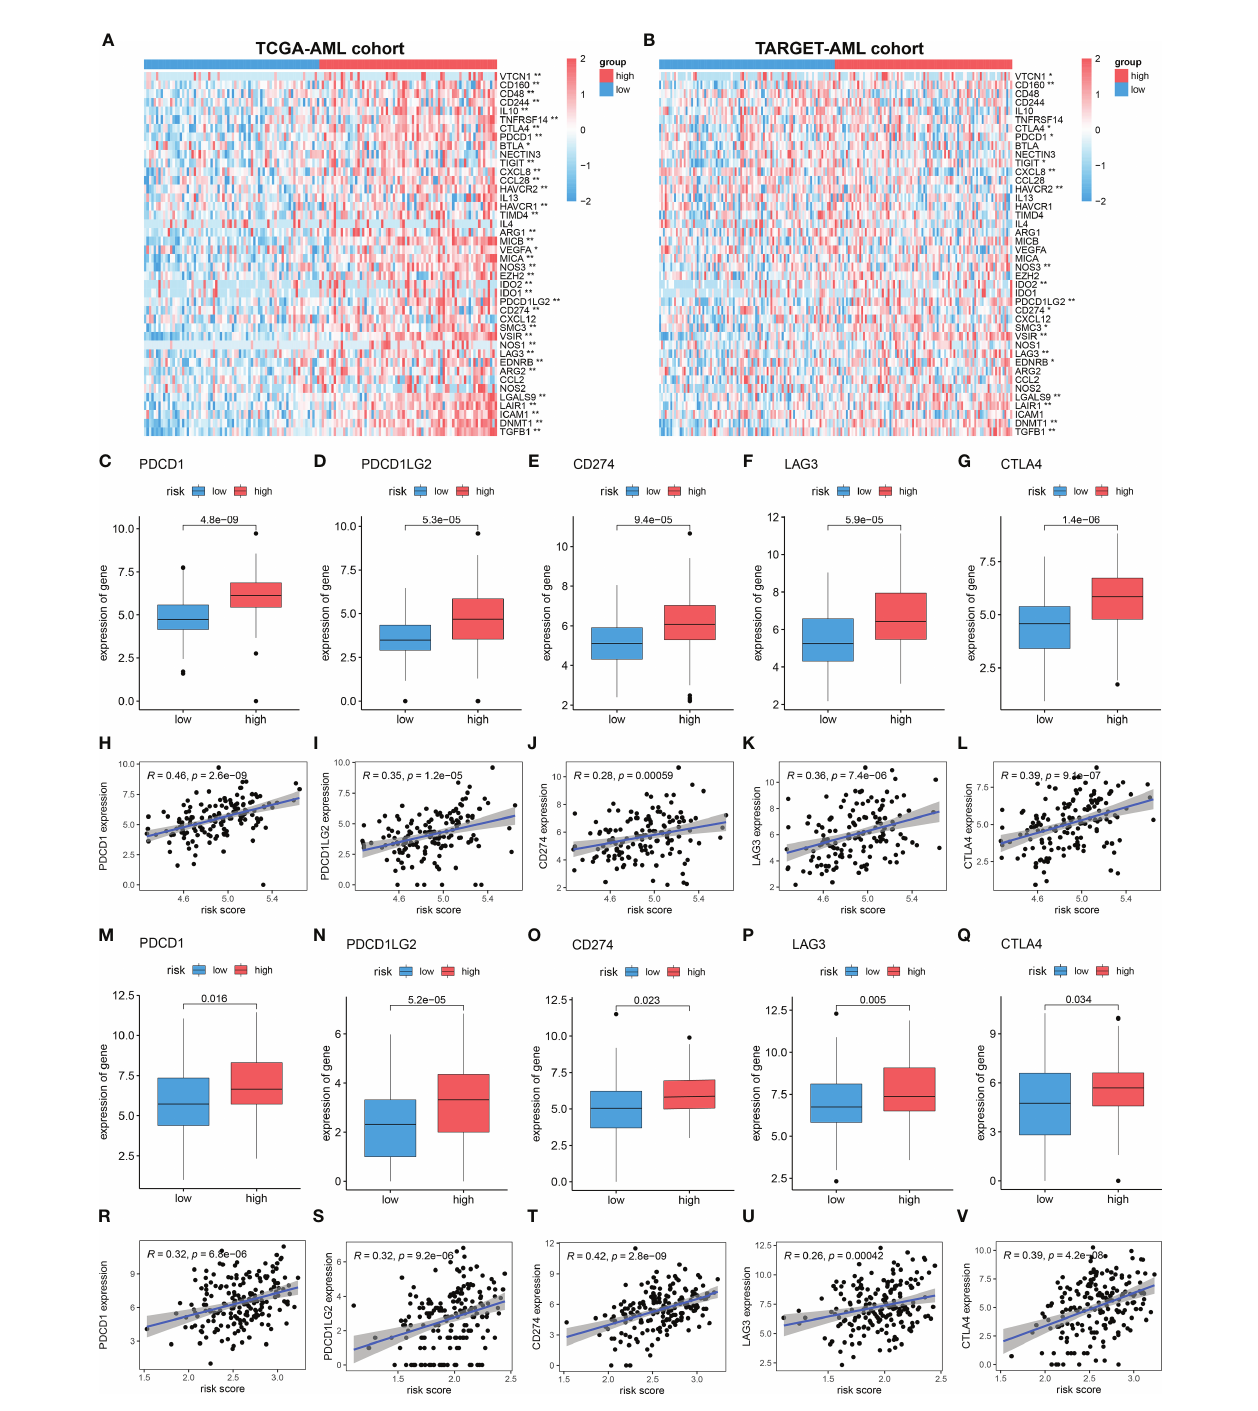
FIGURE 8 | Immunosuppressive microenvironment in high MRG risk group. (A, B) Heatmaps of the immunosuppressive genes in high and low MRG risk groups in TCGA (A) and TARGET (B) . (C – L) Expressions of 5 immune checkpoints (PD1(PDCD1), PDL1(CD274), PDL2(PDCD1LG2), LAG-3, and CTLA-4) in two MRG risk groups and their correlation with MRG risk score in AML-TCGA patients. (M – V) Expressions of 5 immune checkpoints (PD1(PDCD1), PDL1(CD274), PDL2 (PDCD1LG2), LAG-3, and CTLA-4) in two MRG risk groups and their correlation with MRG risk score in AML-TARGET patients. MRG, mitochondria-related gene; TCGA, The Cancer Genome Atlas. *p < 0.05 and **p < 0.01, high risk group versus low risk